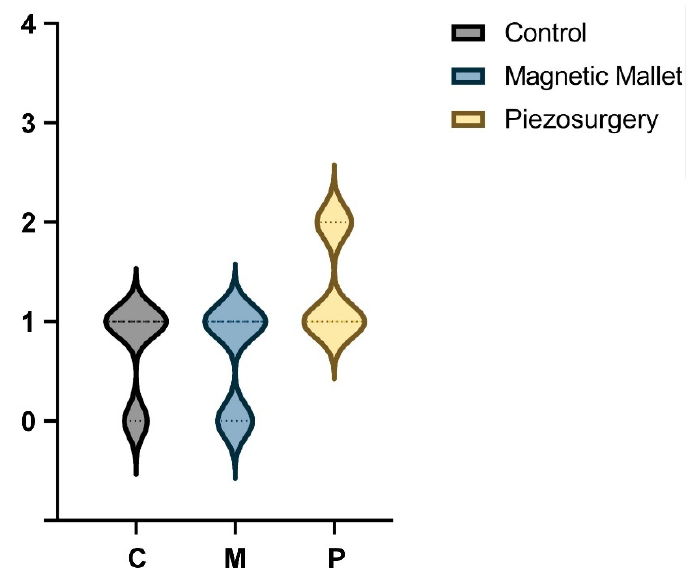
Figure 4. Violin plot of healing distribution (WHI).